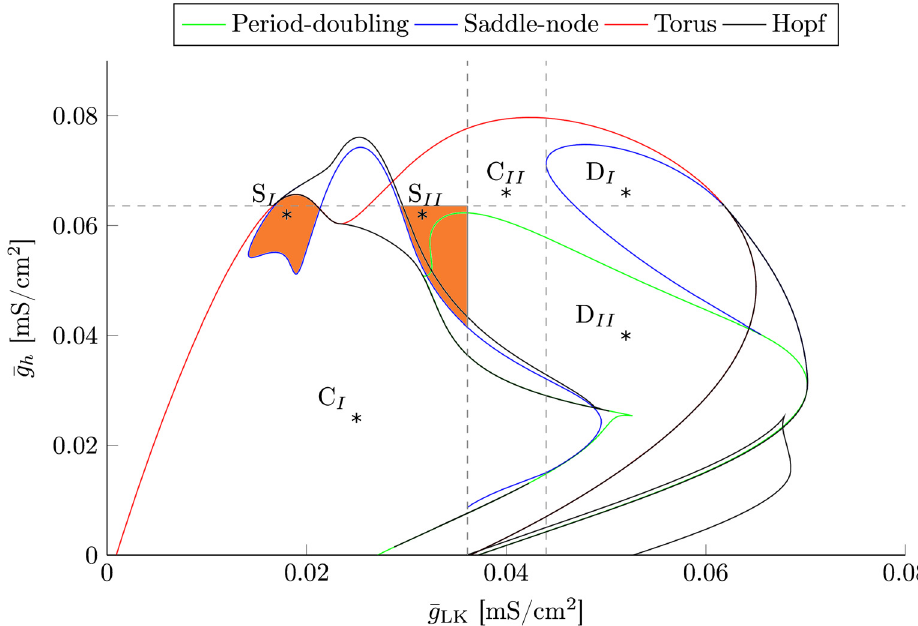
Fig 2. Two-dimensional bifurcation analysis. Here, we illustrate the bifurcation diagram of the isolated and (cid:2) g . The interaction between the currents thalamus with respect to the two key parameters (cid:2) g h LK incorporated into the thalamic module results in the emergence of two torus bifurcations via a blue sky catastrophe. They lead to spindle oscillations in the orange shaded regions. The left spindle regime (S I ) is encased by a Hopf and a torus bifurcation, whereas the right spindle regime (S II ) is constrained by two global bifurcations that are indicated by the dashed gray lines. The vertical line marks the emergence of the torus bifurcation, whereas the horizontal gray line marks the cusp bifurcation where the two saddle-nodes that accompany the left torus bifurcation vanish. The torus bifurcation on the right marks the transition from spindle oscillations to delta oscillations. The labeled points mark the parameter settings utilized in Fig 3, which are given in Table 1.